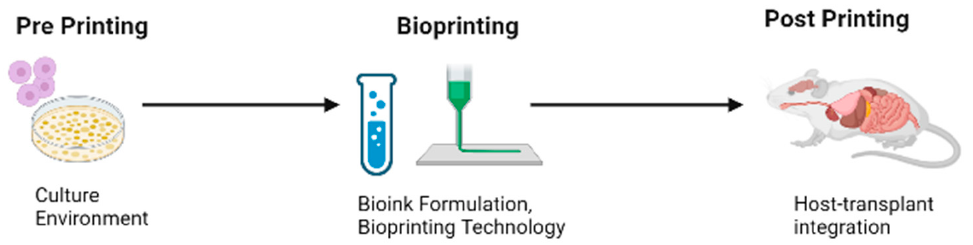
Figure 3. A schematic of factors under consideration for the bioprinting of stem cells.